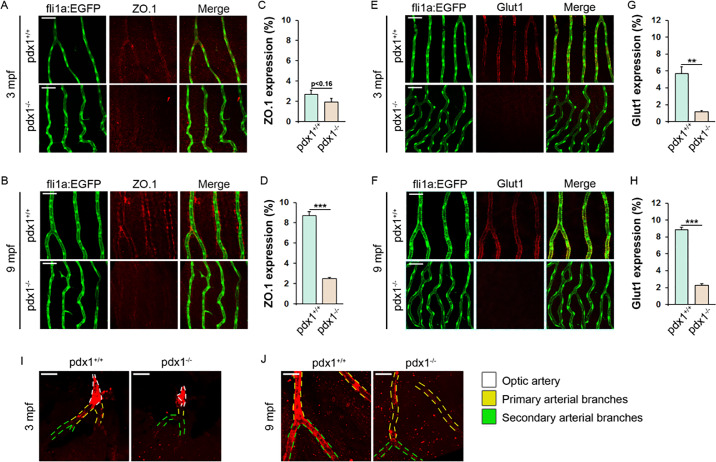

Pdx1 mutants demonstrate BRB disruption. Retinal flat mounts of 3- and 9-month-old pdx1 mutants and controls, transgenic for fli1a:EGFP and stained with anti-ZO.1 antibody (A, B), or anti-Glut1 antibody (E, F). mpf, months post-fertilization. fli1a:EGFP transgene expression (left) and overlap demonstrated in merged images (right). Size bars indicate 50 µm. Quantification of ZO.1- (C, D) and Glut1- (G, H) expression in retinal vessels, in 10 regions from 3 individual fish per group, from samples as in (A, B, E, F). ***P < 0.001, **P < 0.01. (I, J) Retinal flat mounts labeled with transgelin1 antibody (red) at 3 mpf (I) and 9 mpf (J). Arteries are outlined with dashed lines based on the presence of autofluorescent erythrocytes. Optic artery, primary arterial branches, and secondary arterial branches are distinguished by color as indicated. Transgelin1-positive vascular mural cells are associated with primary (yellow dashed lines) or both primary and second order arterial branches (green dashed lines) in 3- and 9-month-old controls, respectively. In 3- and 9-month-old mutants, coverage by transgelin1-positive cells in primary and second-order branches are not observed. Size bars indicate 50 µm.